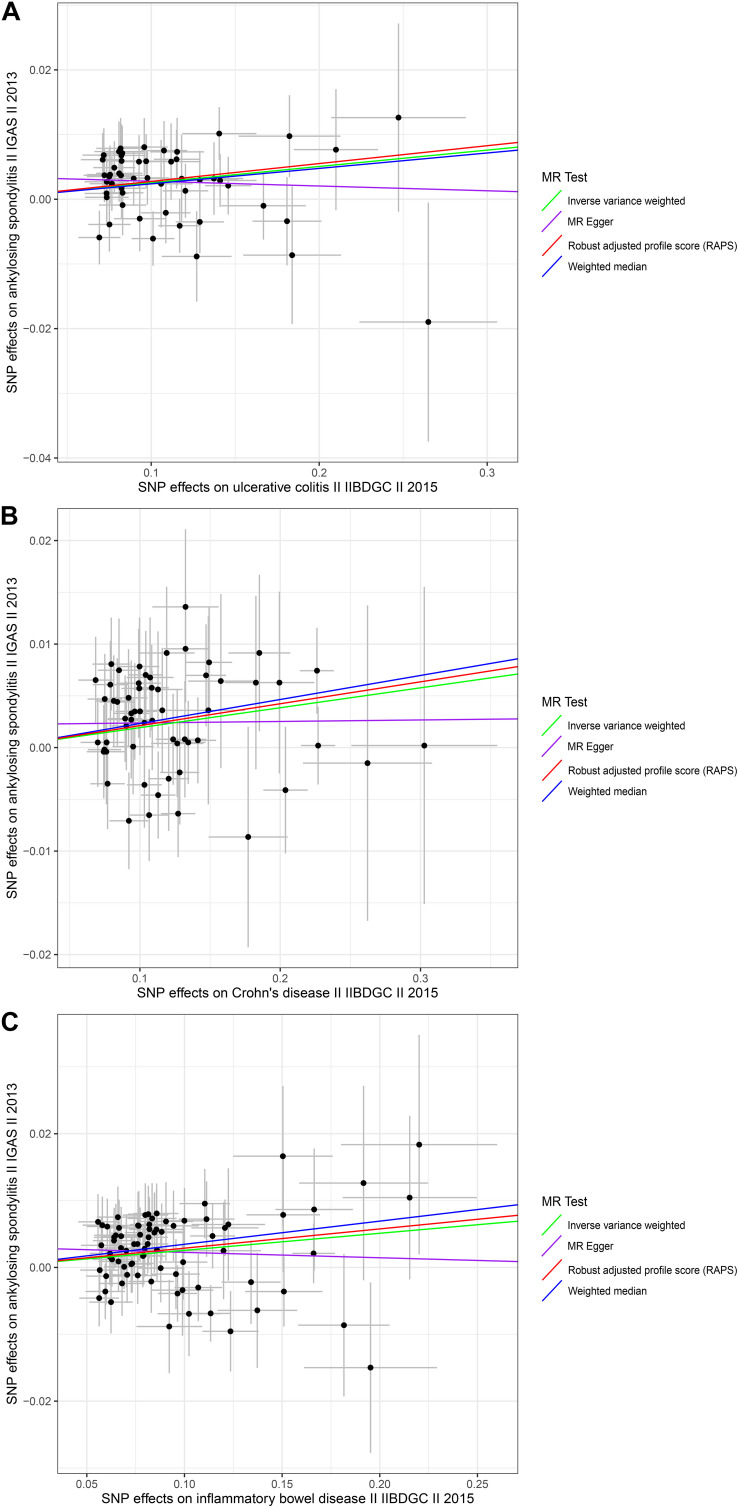
Scatter plots of the genetic associations with inflammatory bowel disease against ankylosing spondylitis risk using different MR methods. (A) Ulcerative colitis against ankylosing spondylitis risk; (B) Crohn’s disease against ankylosing spondylitis risk; and (C) inflammatory bowel disease against ankylosing spondylitis risk. The slopes of each line represent the causal association for each method. The green line represents the inverse variance weighted estimate, the purple line represents the MR-Egger estimate, the red line represents the MR.RAPS estimate, and the blue line represents the weighted median estimate.